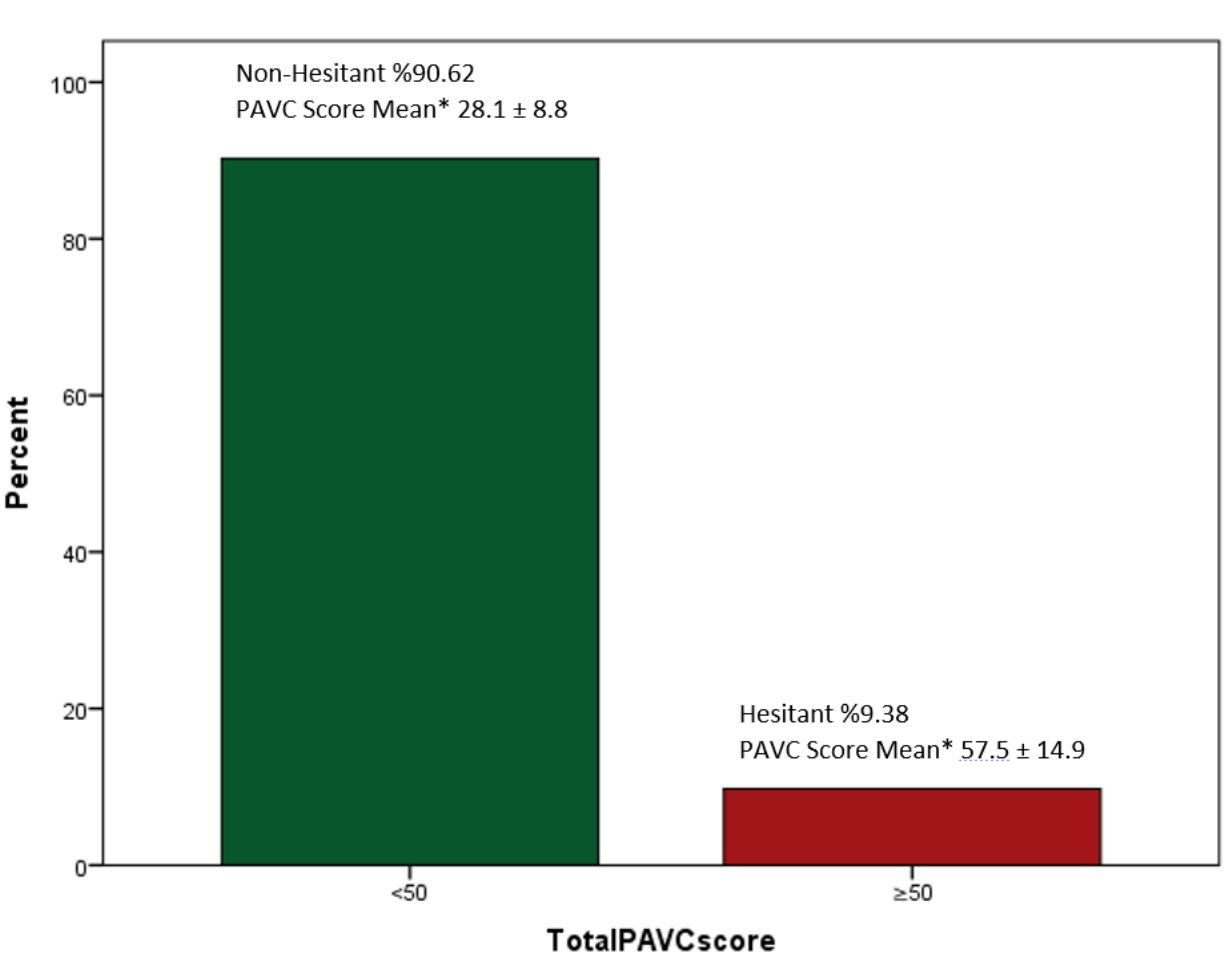
Figure 1. Participant Parent Attitudes about Childhood Vaccine (PACV) Scores Non- Hesitant/Hesitant. Mean ± SD: Average, standard deviation. Table 2. The Relationship between Parental Attitudes about Childhood Vaccines and Characteris- tics of Participating Parents.